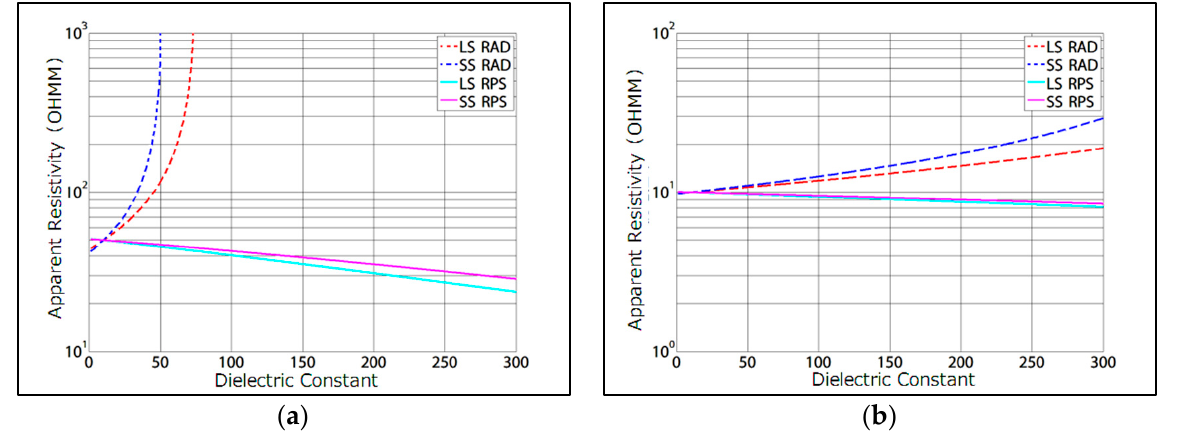
Figure 4. The measured resistivity curve varies with permi tt ivity: ( a ) real resistivity equal to 50 ohm.m; ( b ) real resistivity equal 10 ohm.m.